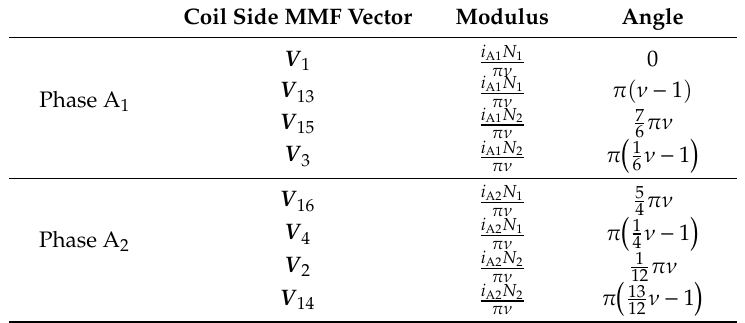
Table 1. Coil side magnetomotive force (MMF) vectors of phase A 1 and phase A 2 of the proposed